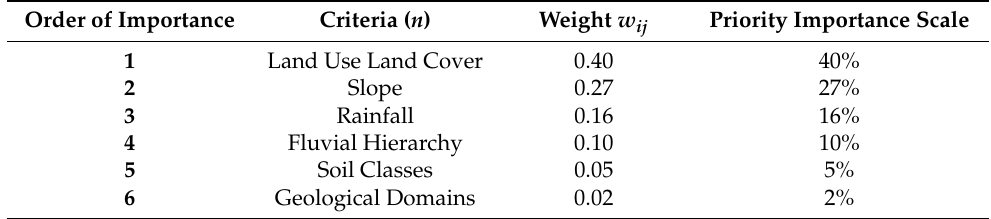
Table 6. Criteria ( n ) and weight coefficients in priority hierarchy obtained after AHP